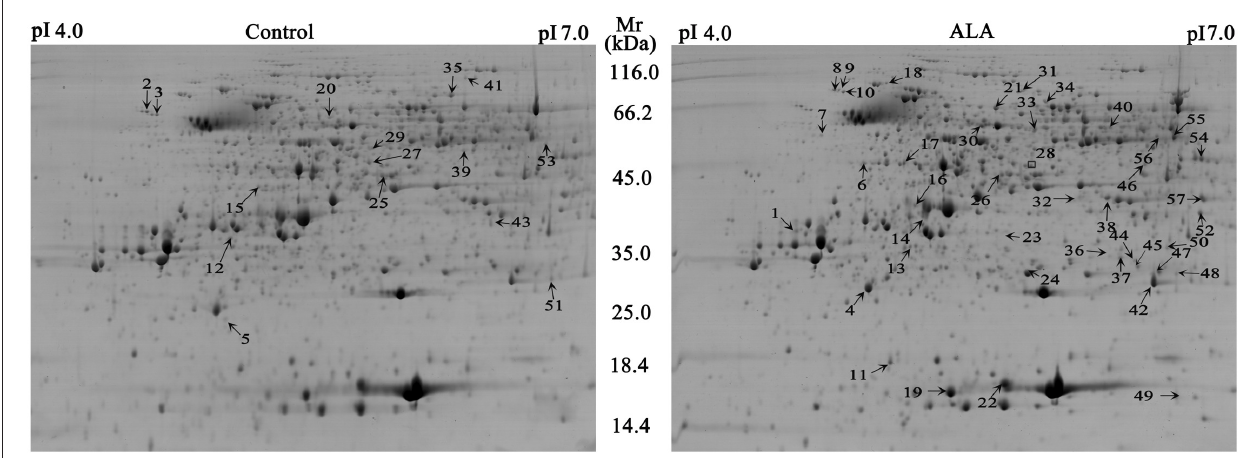
FIGURE 2 | Representative 2-DE gel images of ALA treatment and the control in apple skin. Nearly 500 resolved spots were detected with Mr ranging from 116.0 to 14.4 kDa and pI ranging from 4.0 to 7.0. A total of 57 spots (marked with arrow and number) were identified as differentially expressed and of these, 15 proteins were down-regulated (left), whereas 42 proteins were up-regulated in ALA treatment (right). One spot was unsuccessfully identified (marked with